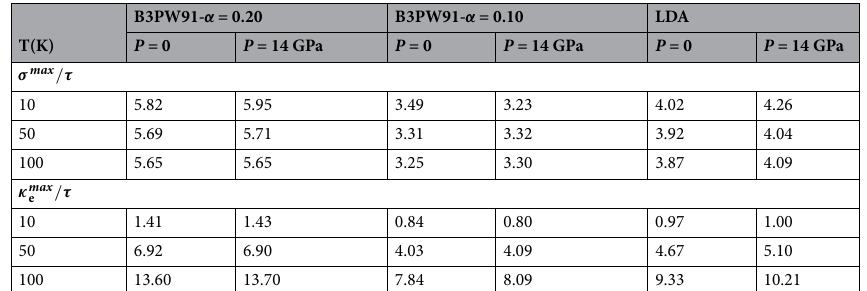
Table 3. The maximum values of electrical conductivity per relaxation time, σ max /τ , and electronic part of thermal conductivity per relaxation time, κ max e /τ , of CeIn 3 at P = 0 and 14 GPa using the B3PW91 XCF with α = 0.20, 0.10 and LDA XCF at specified temperatures T = 10, 50, and 100 K. The units of σ max /τ and κ max 14 10 12 W are 10 µ� ms and cmKs ,